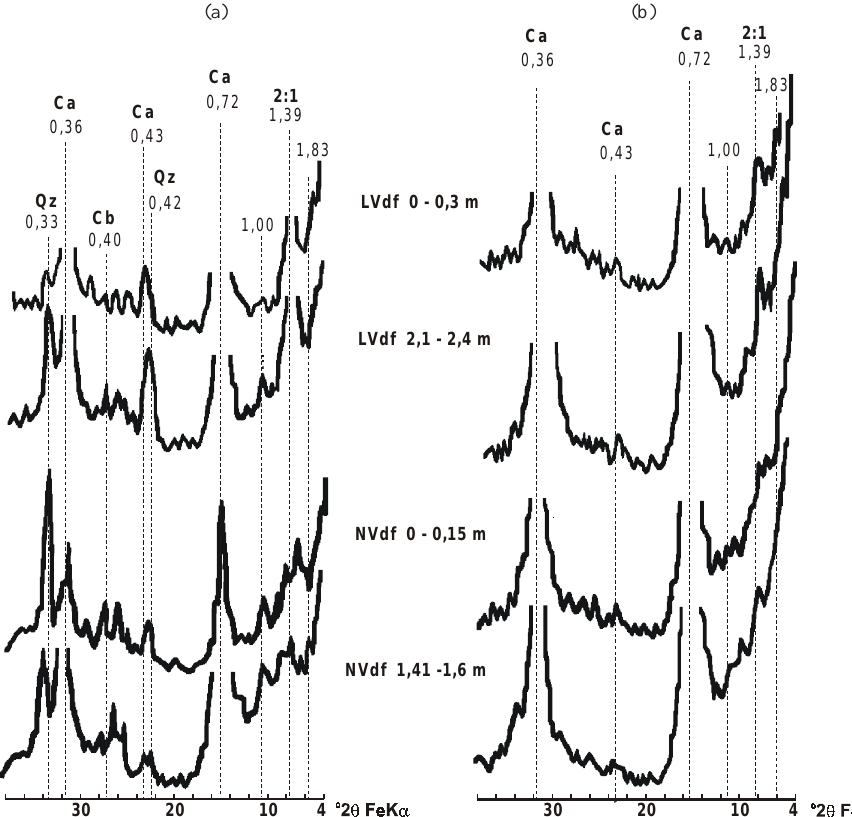
Figura 3. Difratogramas de raios-X da fração argila grossa (a) e argila fina (b) (espaçamento “d” em nm), em duas profundidades, do Latossolo Vermelho distroférrico típico (LVdf) e do Nitossolo Vermelho distroférrico típico (NVdf). Ca = caulinita, 2:1 = argilomineral 2:1, Qz = quartzo, Cb =